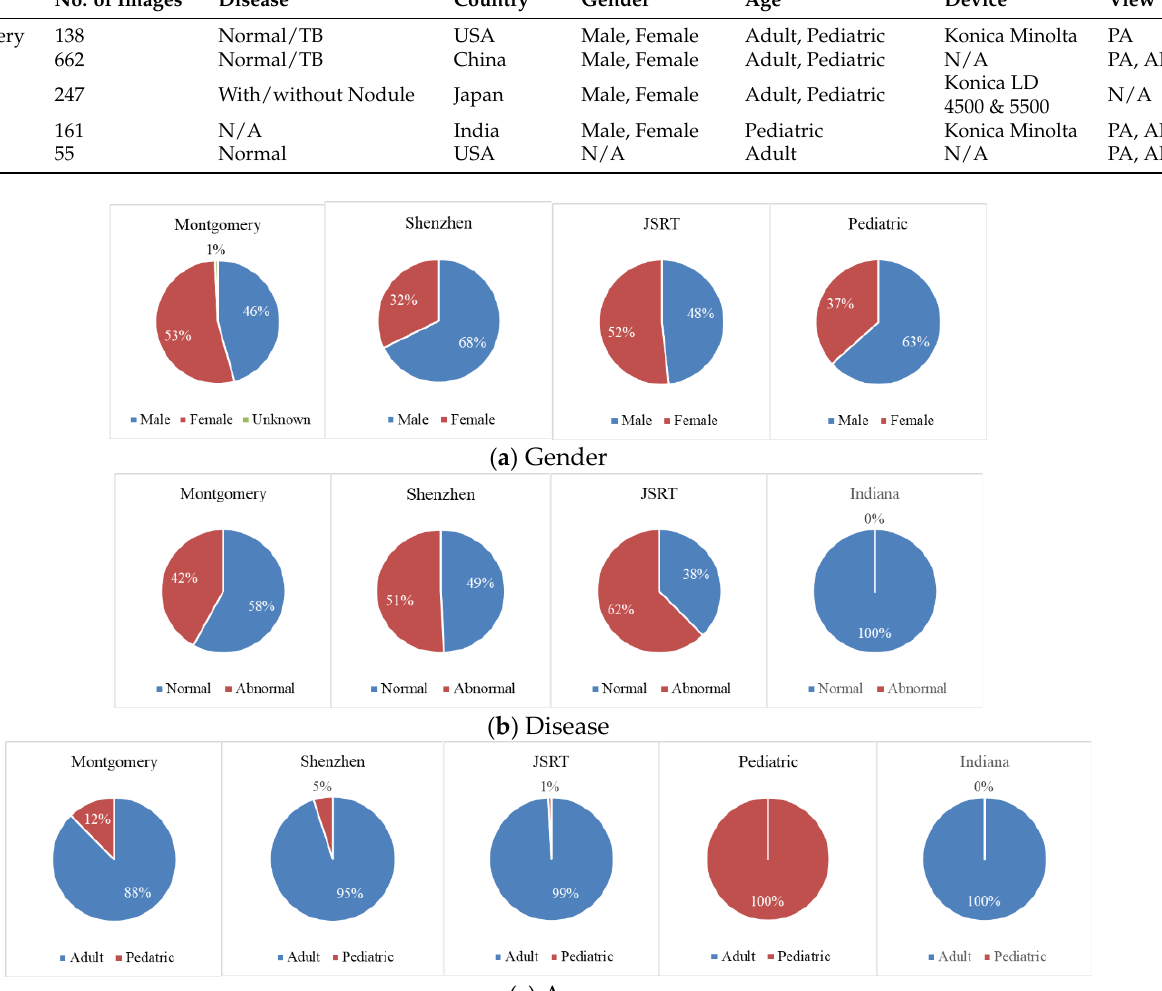
Figure 2. Comparison of datasets with respect to the percentage of gender, age, and disease catego- ries.